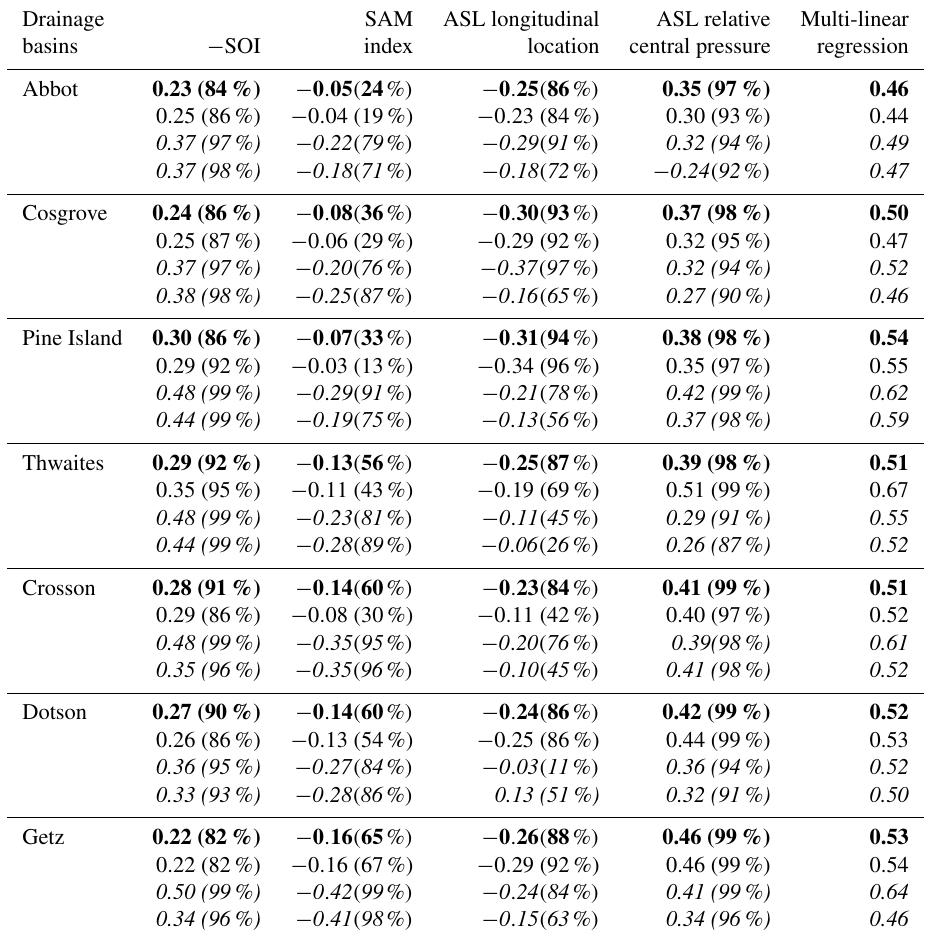
Table 4. Correlation R between − SOI, SAM, and ASL indices and MAR surface melt rates (bold), MAR number of melt days (regular), number of melt days from satellite products (italic, first value for Nicolas et al. (2017) and second for Picard et al. (2007)), over individual ice shelves in summer. The statistical significance (Welch’s t test) is written within brackets. The last column shows the correlation of a multi-linear regression to the four indices using a least absolute shrinkage and selection operator (LASSO, Tibshirani